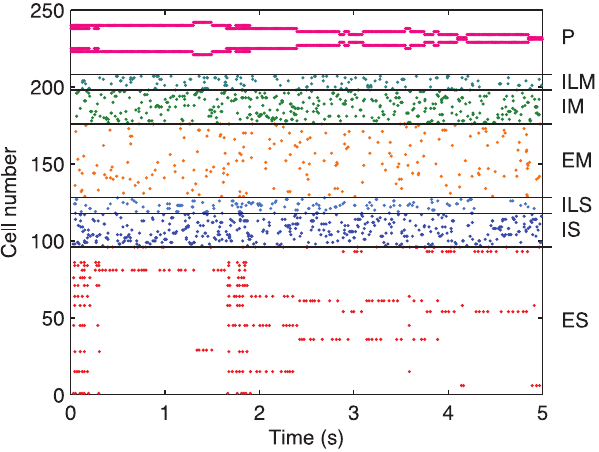
Figure 2. Baseline spiking before learning. Raster of spikes from individual cells: ES, excitatory sensory units; IS, fast-spiking inhibitory sensory units; ILS, low-threshold inhibitory sensory units; EM, excitatory motor units; IM, fast-spiking inhibitory motor units; ILM, low-threshold inhibitory motor units; and P, proprioceptive input units.